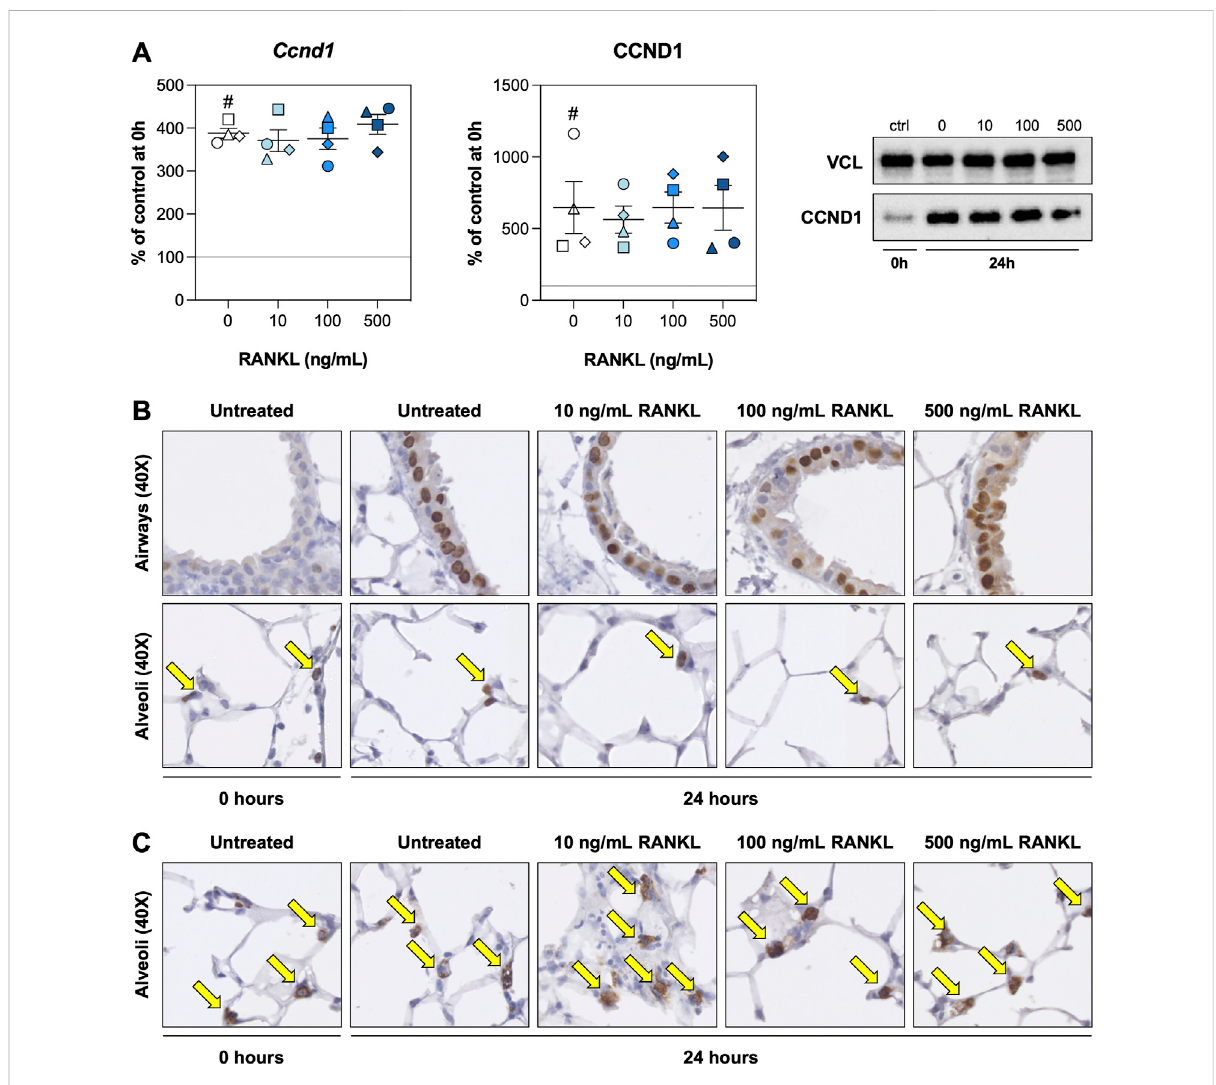
FIGURE 3 Cellproliferation.Slicesweresampledafterslicing(0 h)andafter24 hofincubationwithoutorwith10,100,or500 ng/mlRANKL( n =4).Cyclin D1 mRNA and protein expression (A) were analyzed to assess whether cell proliferation was affected by RANKL. To visualize proliferating cells and ATII cells (arrows), we stained sections for KI67 (B) and SFTPC (C) , respectively. Values depict individual experiments performed in triplicate and are accompaniedwiththearithmeticmean(horizontalline)±standarderrorofthemean(errorbars).( # indicates p < 0.05betweenuntreatedslices at 0 and 24